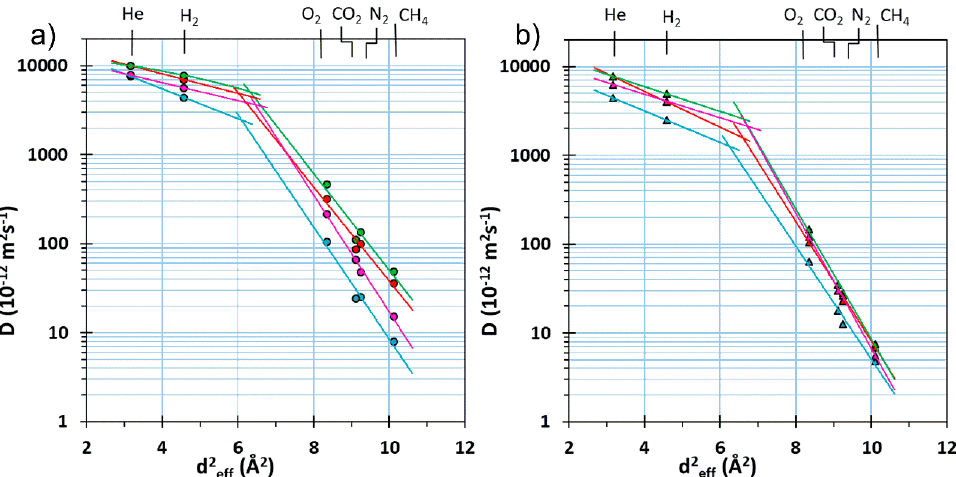
Figure 5. Correlation of the diffusion coefficient and effective gas diameter [46] for the MeOH-treated PIM-Trip(H 2 )-TB (green), PIM-Trip(Me 2 )-TB (blue), PIM-EA(H 2 )-TB (violet) and PIM-EA(Me 2 )-TB (red) membranes ( a ), and the same samples after ageing for 102, 407, 119 and 106 days, respectively ( b ). Lines represent the best fit of the data for helium and hydrogen, and for oxygen, carbon dioxide, nitrogen and methane, respectively. Measurements at 25 °C and 1 bar feed pressure.